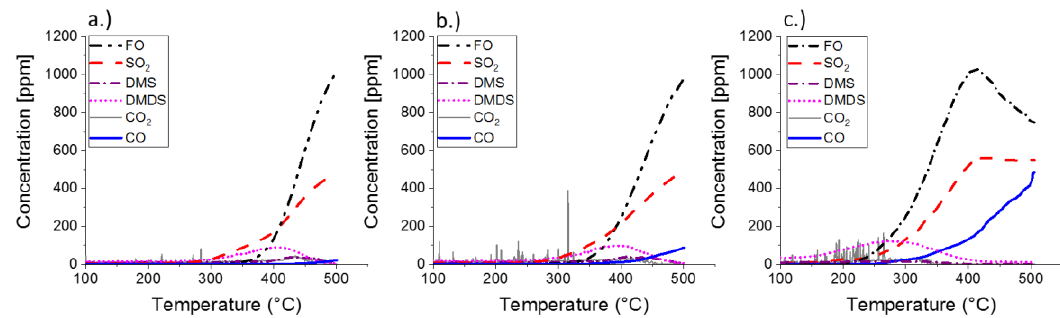
Figure 11. Formation of by-products in the oxidation of the mixture of methanol and methyl mercaptan (500 ppm + 500 ppm) over ( a ) 1.5V/Si; ( b ) 1.5V/Ti and ( c ) 1.5V/SiTi(30) catalysts (feed 500 ppm + 500 ppm, heating rate of 5 °C min −1 ).